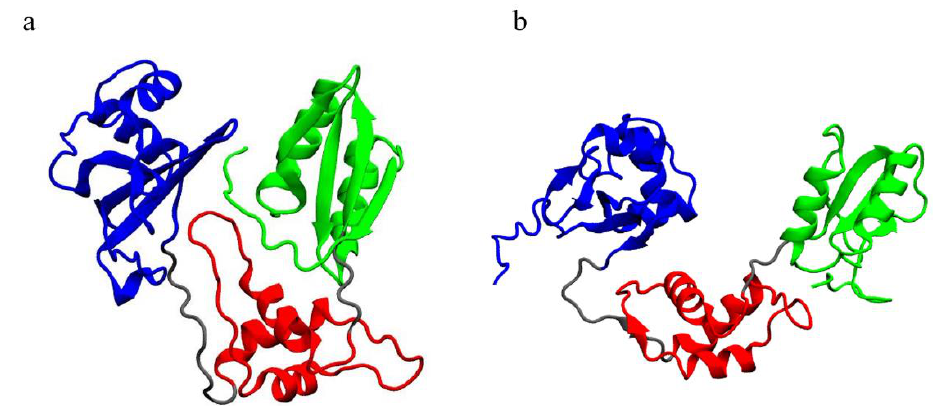
Figure 10. Visualization of the equilibrated trajectories: ( a ) closed WT and ( b ) open WT. Different colors indicate different domains: blue, domain I; red, domain II; green, domain III; grey, linkers. The C-terminal domain is clearly in contact with both domains I and II in the closed conformation.